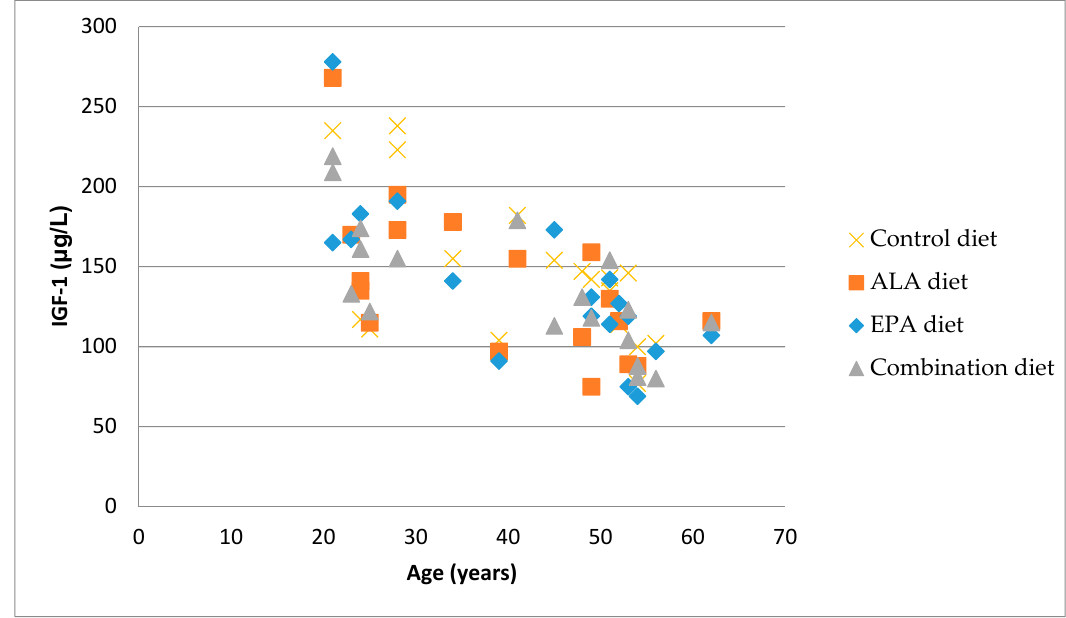
Figure 1. The association between serum IGF-1 levels and age in different diet groups.